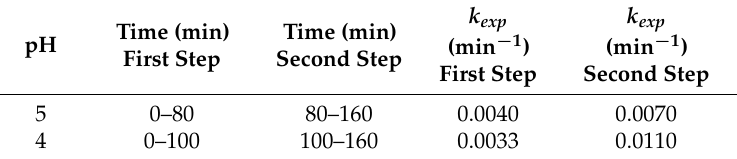
Table 1. Values of k exp of thiosulfate transformation in two